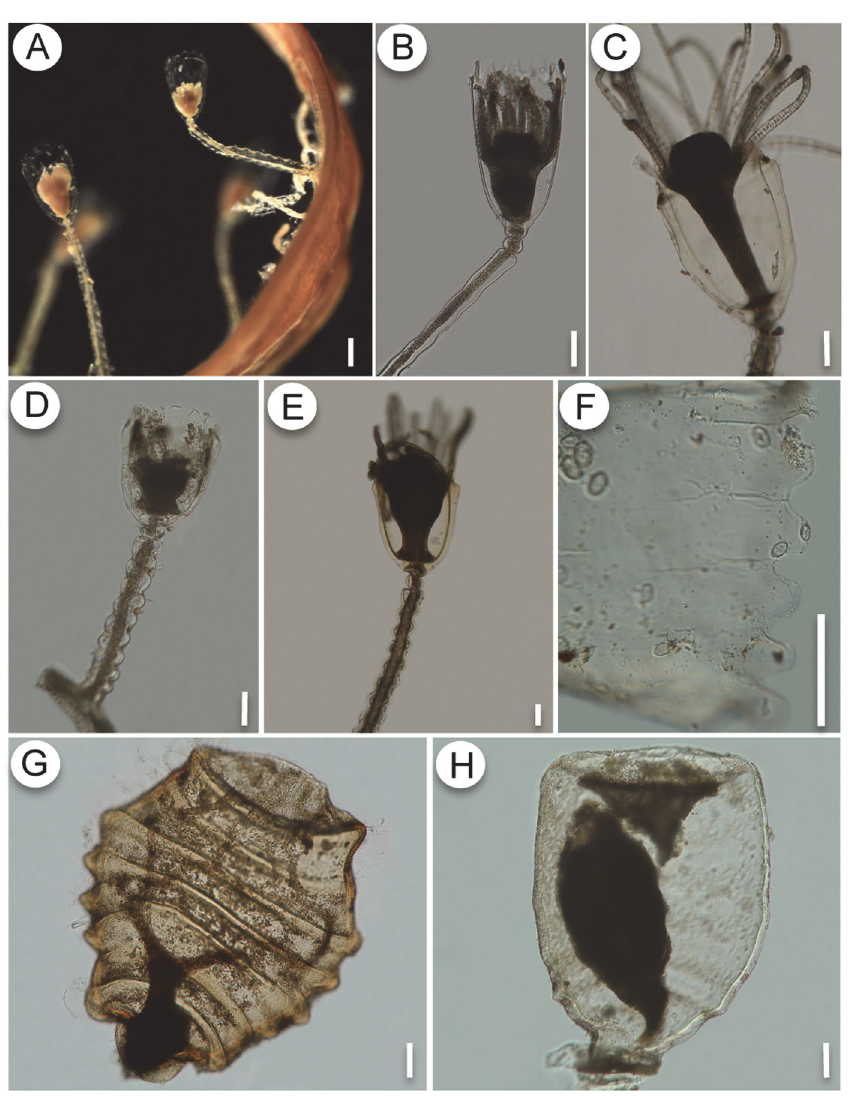
Fig 6. A-C, G: Orthopyxis sargassicola . A: general view of the colony on Sargassum sp.; B-C: detail of the trophosome, showing variation in perisarc thickness of hydrotheca; G: gonotheca. D-F, H: